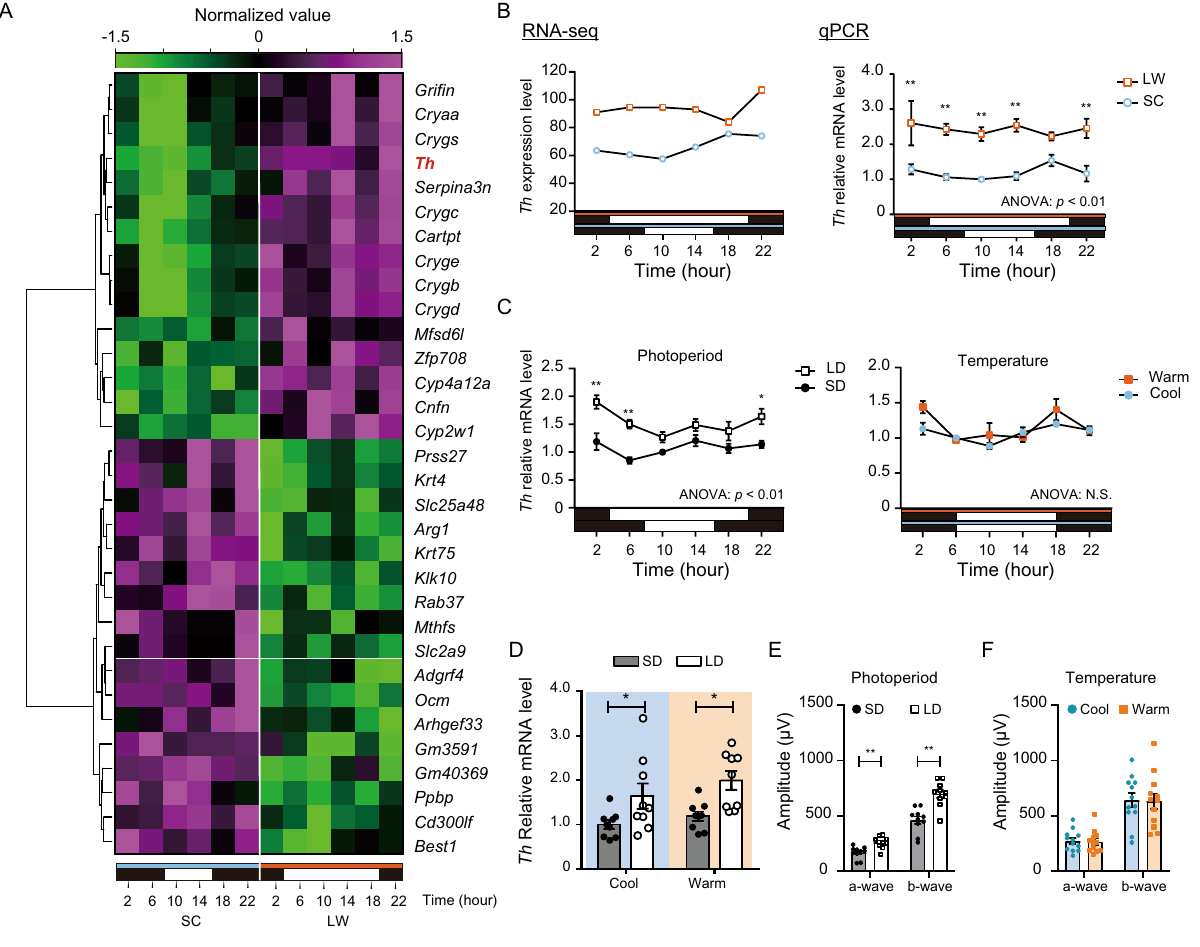
Figure 2. Photoperiodic regulation of Th expression and mesopic ERG. ( A) Hierarchical clustering of 15 genes upregulated under LW conditions and 17 genes upregulated under SC conditions. Heatmap was generated in R (version 4.0.3) with the heatmap.2 function from gplots package (https ://bioco recrg .githu b.io/CRG_RIntr oduct ion/heatm ap-2-funct ion-from-gplot s-packa ge.html). ( B ) Differential expression of Th gene detected by RNA-seq (n = 2) (left) and qPCR (n = 3) (right) in the eyes of the mice kept under SC and LW conditions. Two- way ANOVA and Bonferroni post hoc test were used for qPCR analysis (two-way ANOVA, effect of seasonal cues, F (1, 24) = 77.91, p < 0.01, Bonferroni post hoc test: ** p < 0.01; effect of time, F (5,24) = 0.3711, p = 0.8634; effect of interaction, F (5, 24) = 0.6346, p = 0.6753, mean ± SEM, n = 3). ( C ) Effects of photoperiod (left) or temperature (right) on Th gene expression measured by qPCR (two-way ANOVA, effect of photoperiod, F (1, 24) = 53.76, p < 0.01; effect of temperature, F (1, 24) = 3.647, Bonferroni post hoc test: * p < 0.05, ** p < 0.01; effect of time, F (5,24) = 4.129, p < 0.01 [photoperiod], F (5,24) = 6.008, p < 0.01 [temperature]; effect of interaction, F (5,24) = 1.670, p = 0.1801 [photoperiod], F (5,24) = 1.600, p = 0.1982 [temperature], mean ± SEM, n = 3). ( D ) Effects of photoperiod and temperature on Th expression (two-way ANOVA, effect of photoperiod, F (1, 32) = 14.44, p = 0.0006, Bonferroni post hoc test: * p < 0.05; effect of temperature, F (1,32) = 1.987, p = 0.1683; effect of interaction, F (1,32) = 0.1900, p = 0.6658, mean ± SEM, n = 9). ( E ) Effect of photoperiod on mesopic responses (Student’s t -test, t (18) = 3.825 [a-wave], t (18) = 4.732 [b-wave], ** p < 0.01, mean ± SEM, n = 10). ( F ) Effect of temperature on mesopic responses (Student’s t -test, t (22) = 0.1534 [a-wave], t (22) = 0.08799 [b-wave], p > 0.05, mean ± SEM, n = 10–12). Mesopic ERG was measured using a − 1.0 log(cds/m 2 ) light